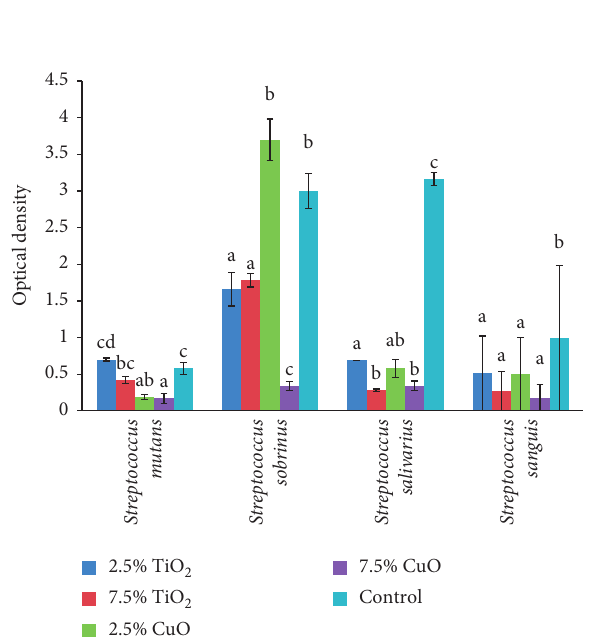
Figure 2: Means and standard deviations ( n � 5) of optical density of the study groups against different strains of Streptococcus .